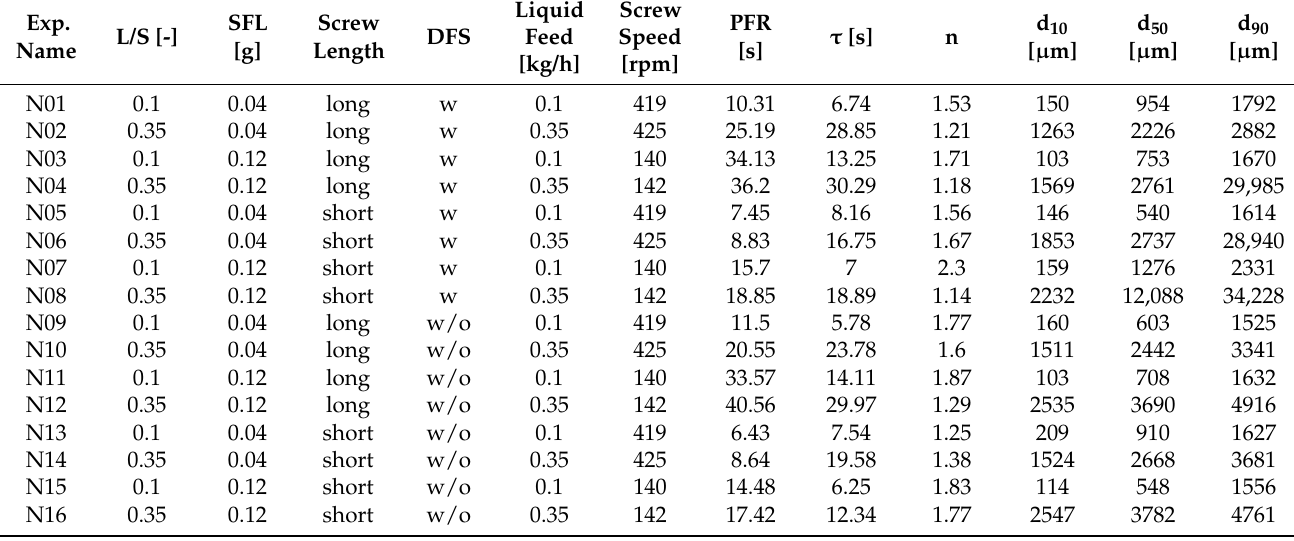
Table A1. Experimental design parameters and